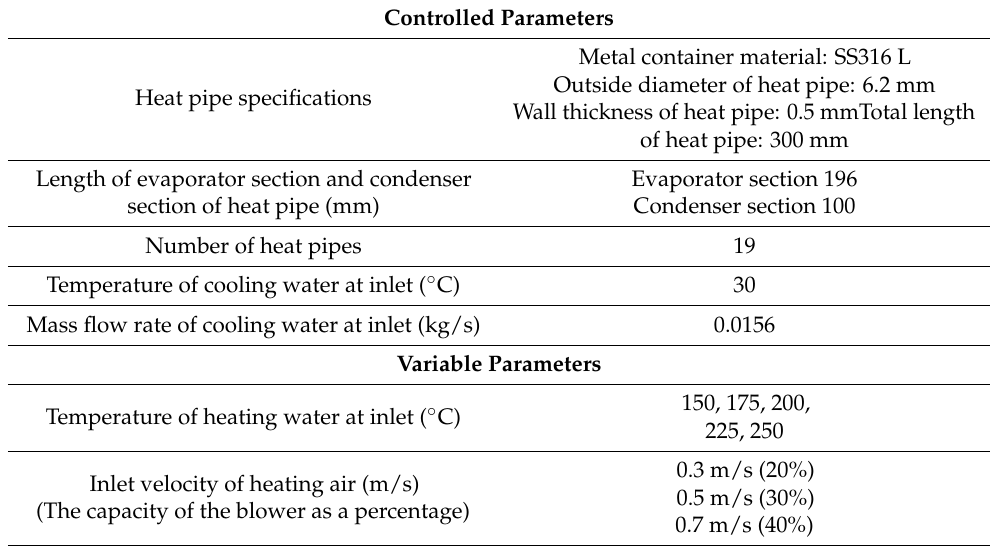
Table 2. Input parameters for the